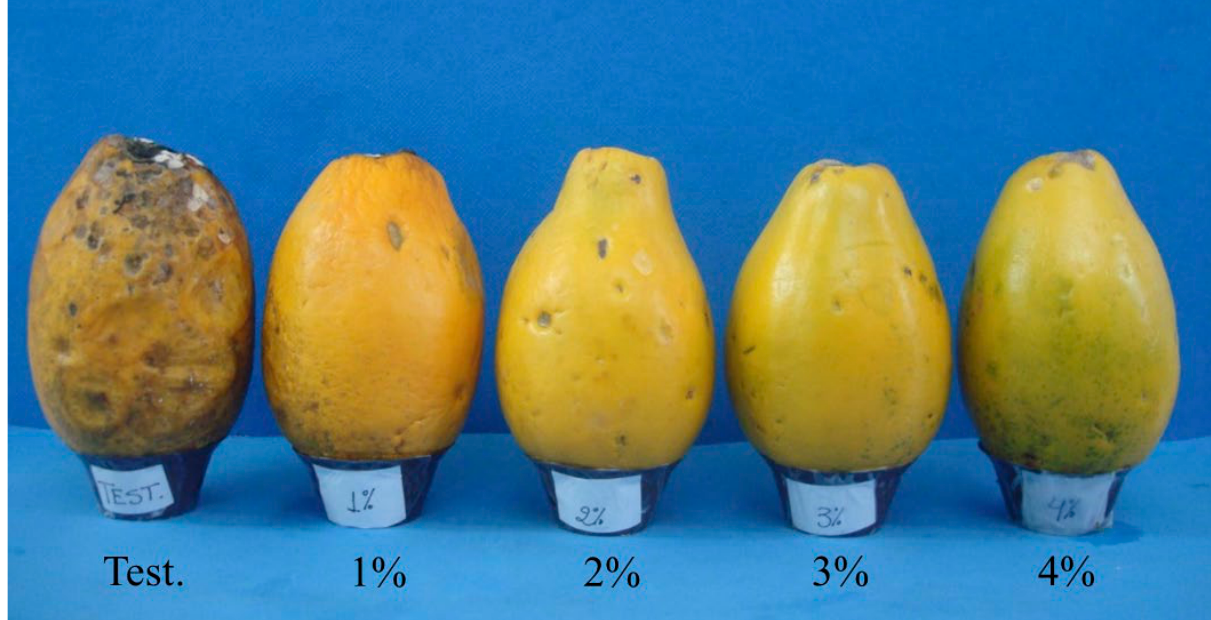
Figure 1. Papaya fruits inoculated with Colletotrichum gloeosporioides and coated with cassava starch. Control (Test.) and cassava starch coating of 1%, 2%, 3% and 4% at 14 d after